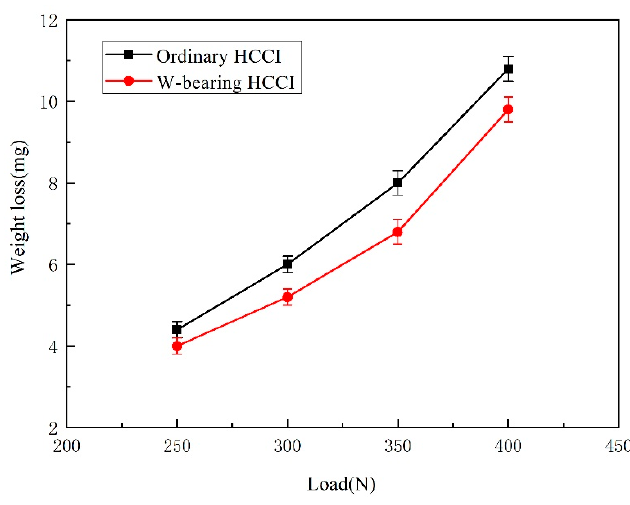
Figure 10. The wear resistance of HCCI.